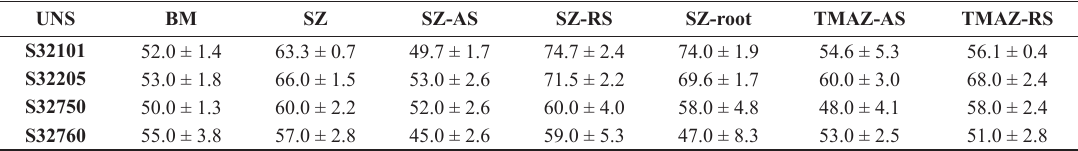
Table 5. Ferrite volume fractions of several regions in the FSW joint (vol.%).